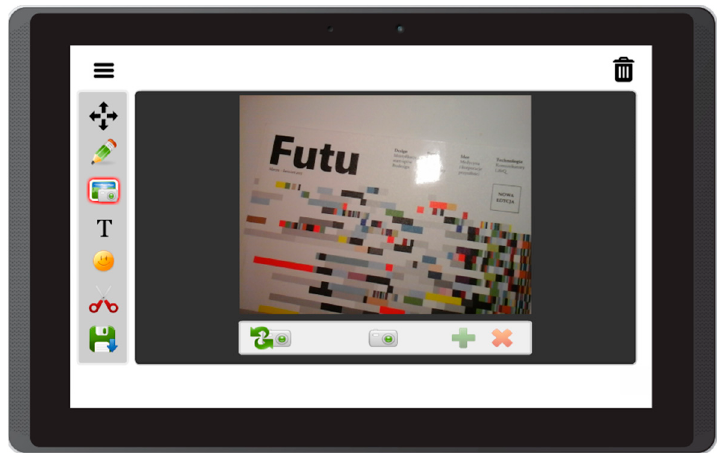
Figure 4. Taking photos with the front and back camera in Aphasia Create (screenshot from an Android tablet).